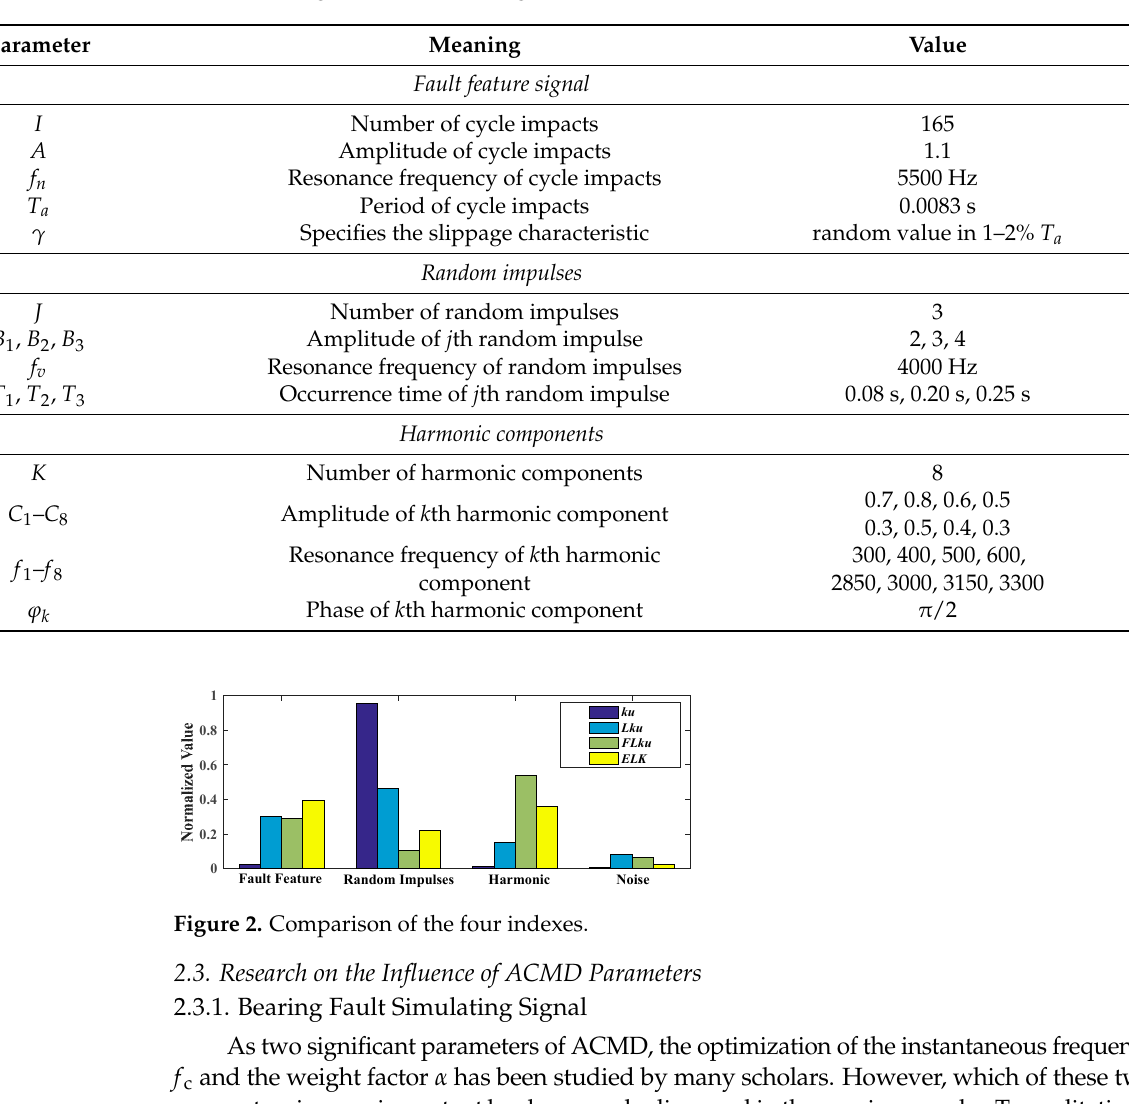
Table 1. Setting of the simulated signal.